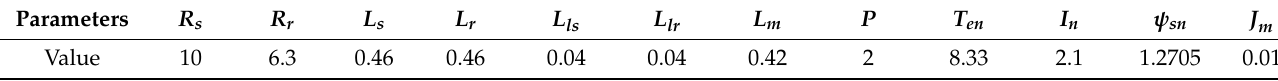
Table A1. Parameters of five-phase IM drive system.